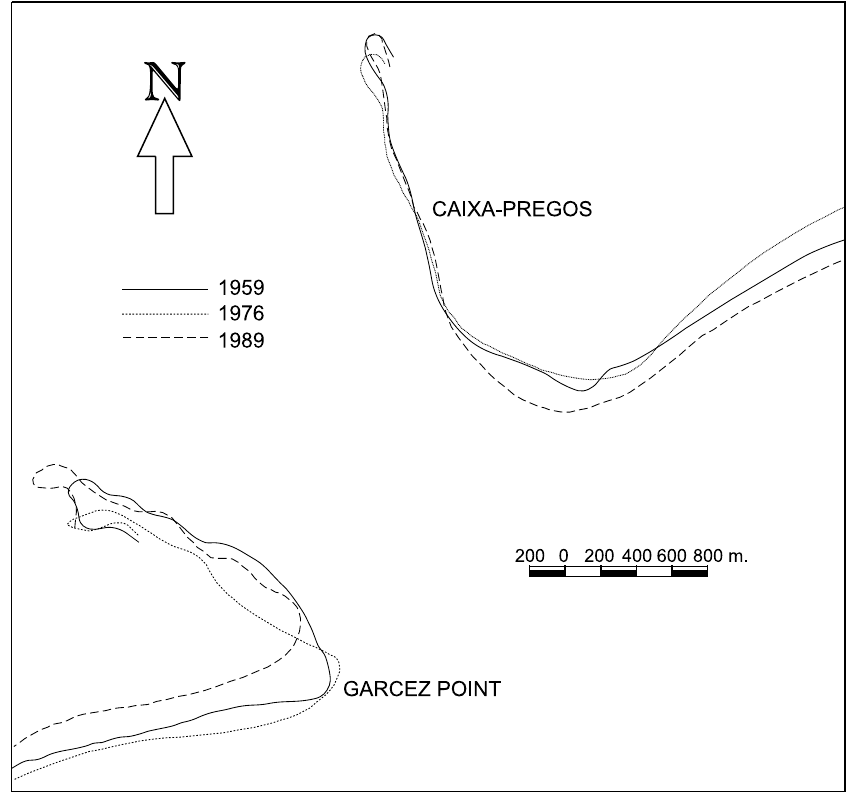
Fig. 6 – Coastlines associated with Garcez Point and Caixa-Pregos in the years 1959, 1976 and 1989.